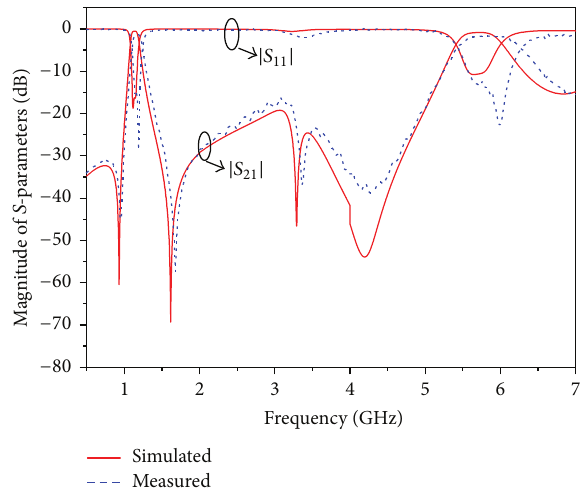
the interdigital coupling capacitor, the rejection band can be extended to the fifth